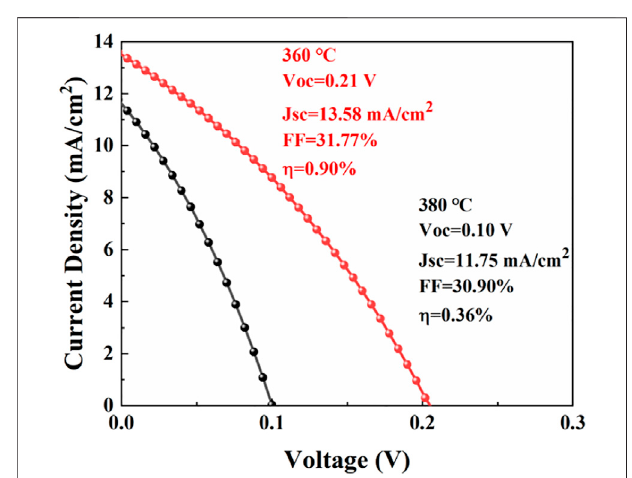
FIGURE 9 | J – V curves of the CuSbS 2 thin- fi lm solar cells based on absorbers annealed at 360 ° and 380 ° C for 30 min.